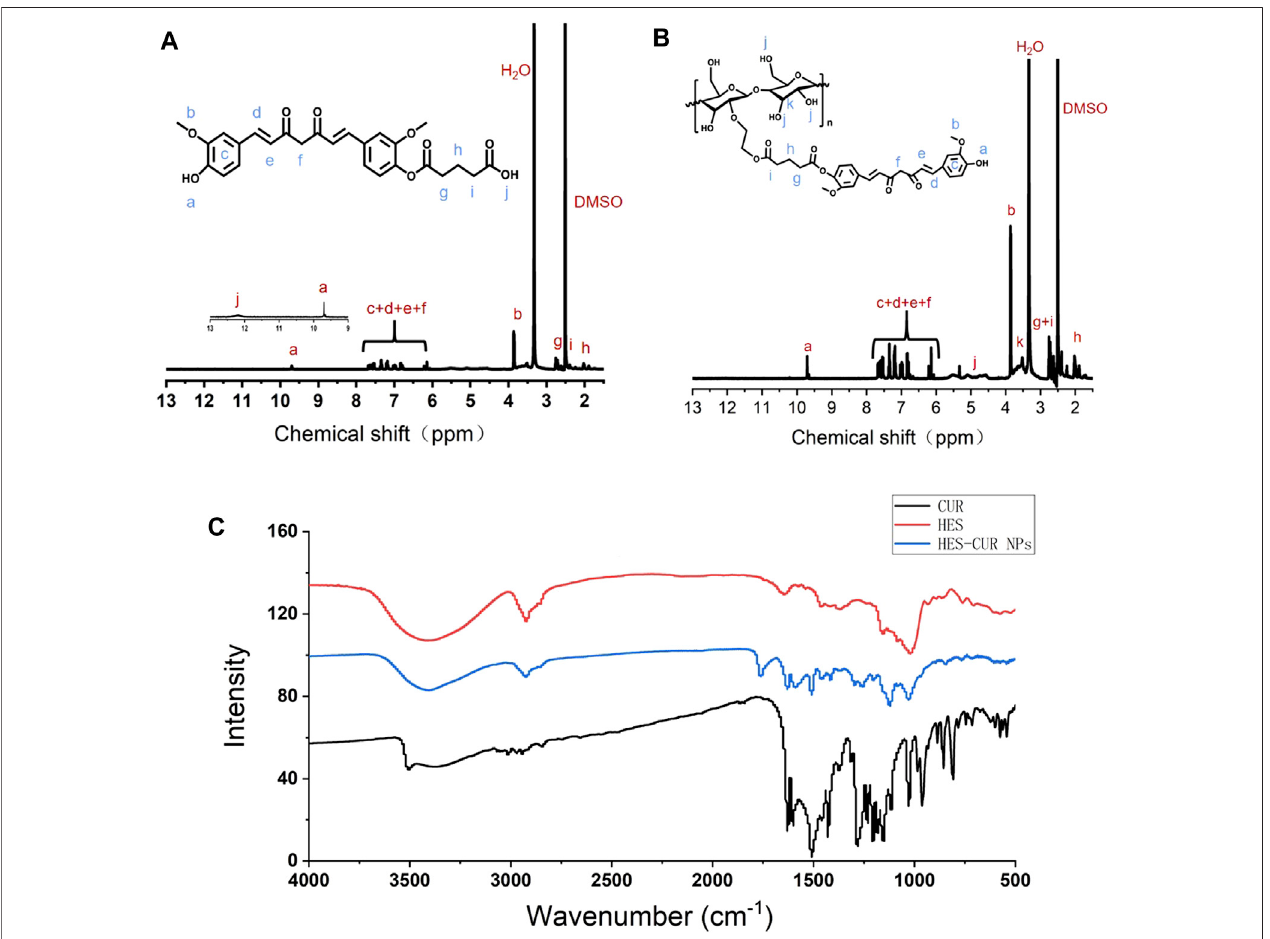
FIGURE 1 | 1 H NMR spectra of (A) CUR-COOH and (B) HES-CUR NP conjugates, and (C) FT-IR spectrum of CUR, HES, and HES-CUR NPs.